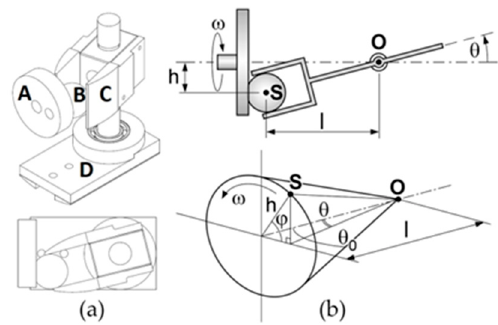
Figure 7. ( a ) CAD model of the spatial cam kinematic joint. ( b ) Functional scheme [1,6].